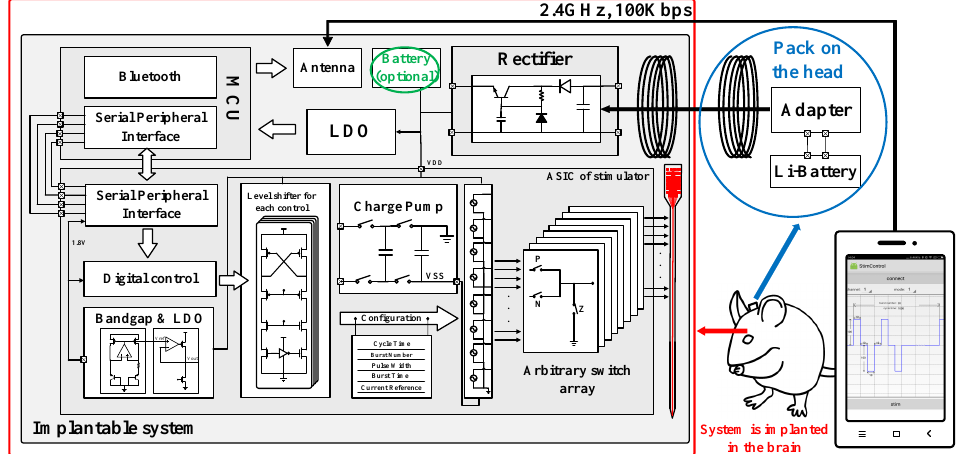
Figure 2. Block diagram of the overall system including the integrated proposed stimulator application-specific integrated circuit (ASIC) chip. The system consists of five parts: (i) the ASIC chip for multiple stimulation pattern generation, control and channel arrangement; (ii) an SPI-based interface connecting the external processing unit and the proposed ASIC; (iii) a Bluetooth-based wireless communication interface; and (iv) the wireless battery charging module. LDO: low dropout